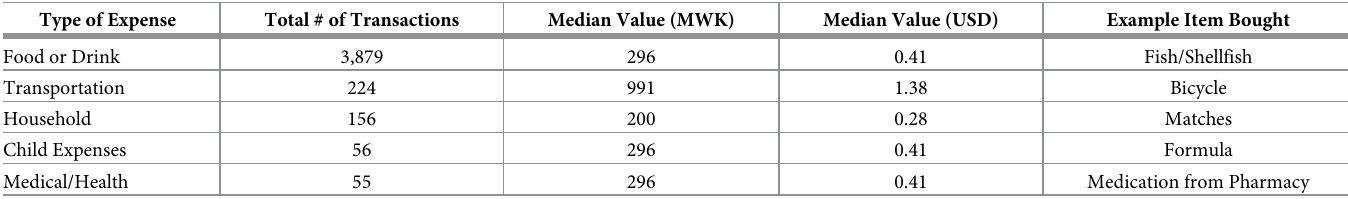
Table 6. Breakdown of outflows for PMTCT by